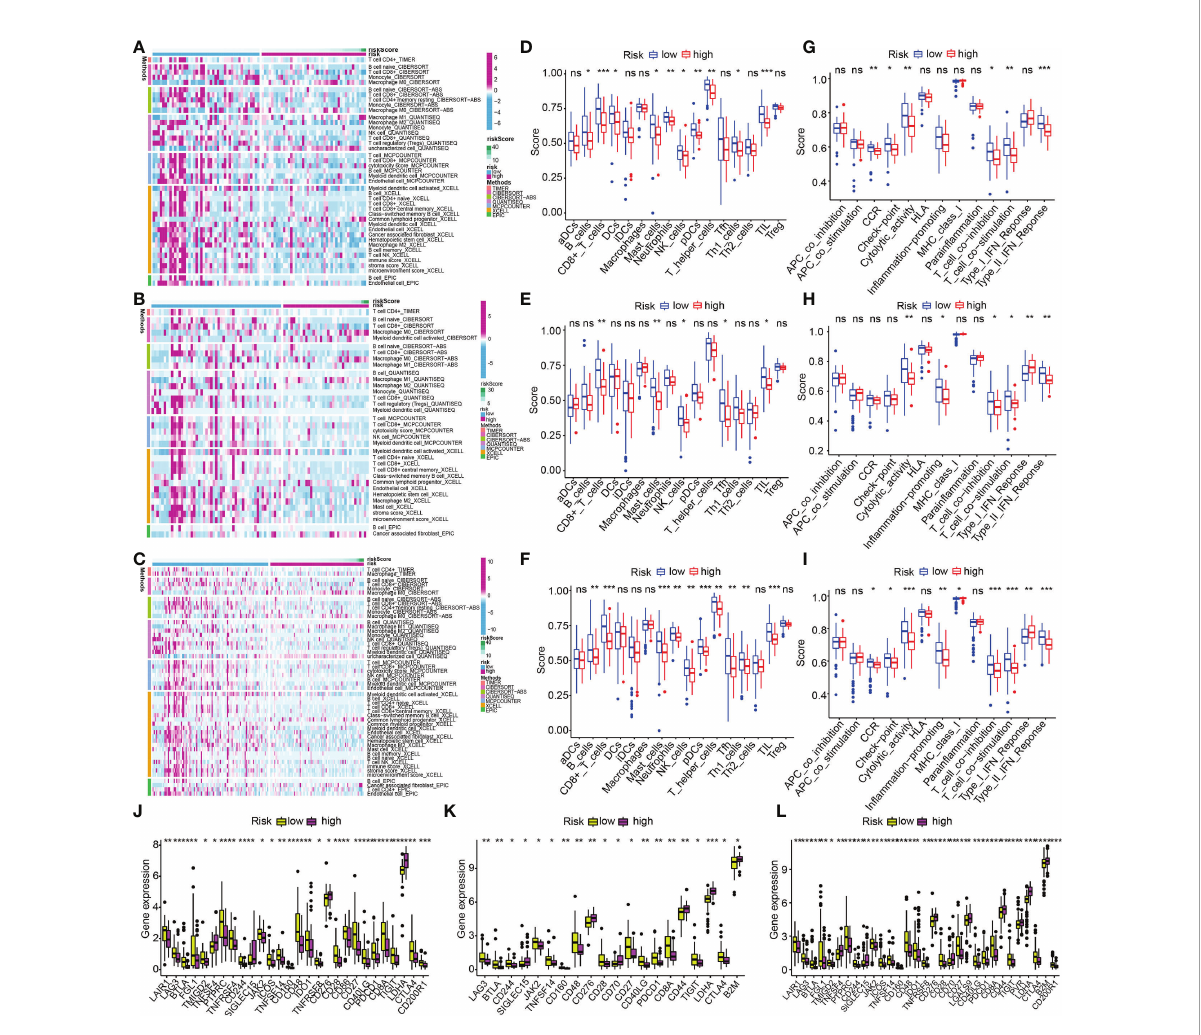
FIGURE 13 ECM-APP-based analysis of tumor immune microenvironment. (A – C) The heat maps showed discrepancies in in fi ltration levels of immune cells across low- and high-risk subgroups premised on the train, test1, and test2 cohorts. The box plots showed discrepancies in ssGSEA scores between two risk subgroups in the (D, G) train cohort, (E, H) test1, and (F, I) test2cohorts. (J – L) The box plots showed discrepancies in immune checkpoint expression in low- and high-risk subgroups premised on the train, test1, and test2 cohorts. (* indicates p <0.05; ** indicates p < 0.01; *** indicates p < 0.001. ns, non-signi fi